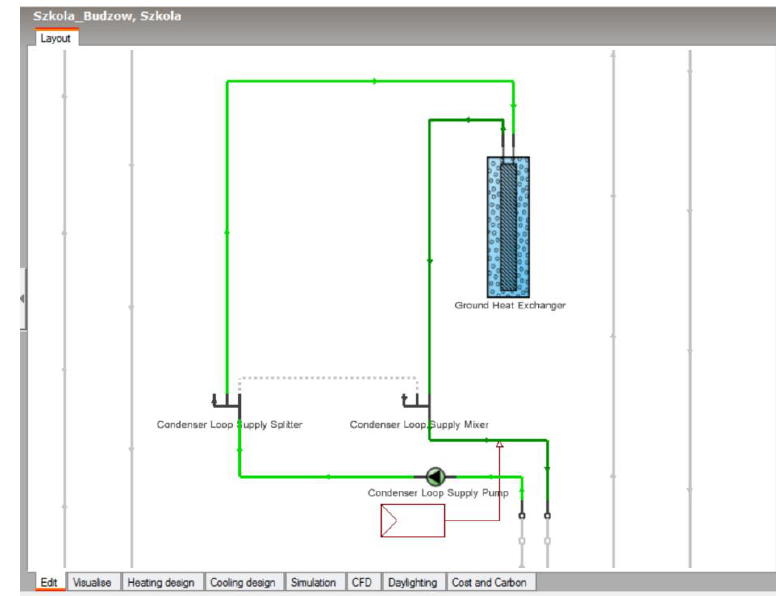
Figure 7. Boreholes modeled in the Design Builder program.